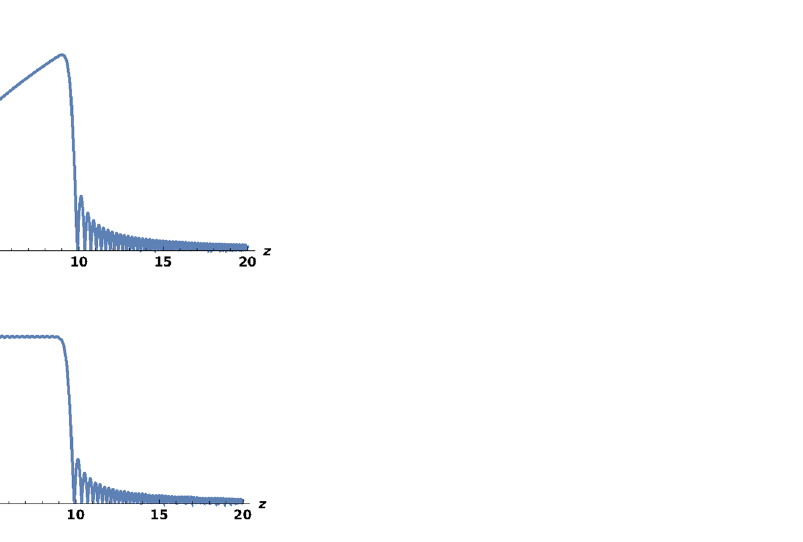
Figure 9. Beampatterns with the same parameters as Figure 6 (top) with the addition of the z offset by imaginary number q = 1/2 (top) and 1 (bottom). The q factor produces stronger source amplitudes at radii greater than 9 mm (beyond the scale shown), which contribute to the emerging pattern at axial range greater than 10 mm. Next, we examine some alternative modifications. The localization property of the summation is illustrated in Figure 10 (top), where only the sum from integer orders 150 to 250 are activated. This translates into a localized area of axial strength from 7 to 12 mm from the transducer surface. An oscillatory term is added to the coefficients and shown in Figure 10 (bottom) using Equation (7) with N mod = 2.5. This modulates the amplitudes of the integer orders within the sum, and thereby serves as a rough equivalent to changing the angle of incidence in conical optical axicon configurations.